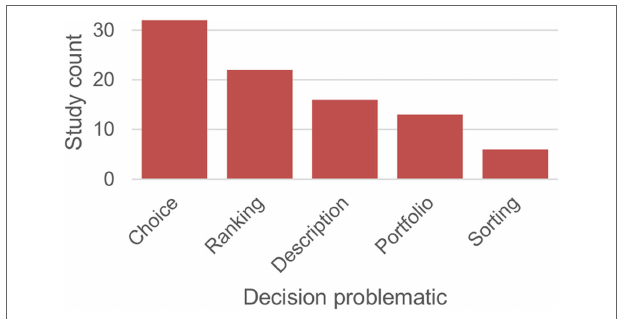
FiGURe 8 | Distribution of problematic types in the reviewed studies